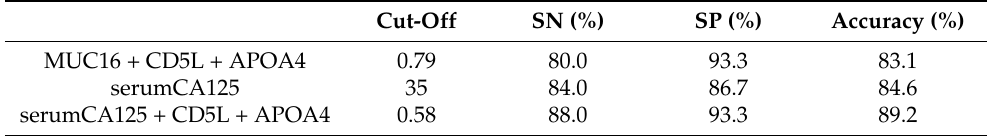
Table 8. The evaluation indicators of the differential models in patients with ovarian